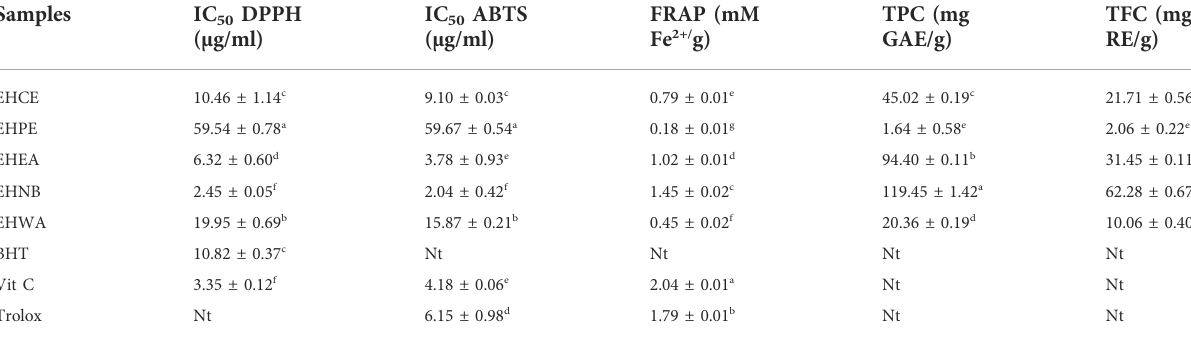
TABLE 1 The antioxidant activities, total phenolic content (TPC), and total fl avonoid content (TFC) of E. humifusa samples. Samples